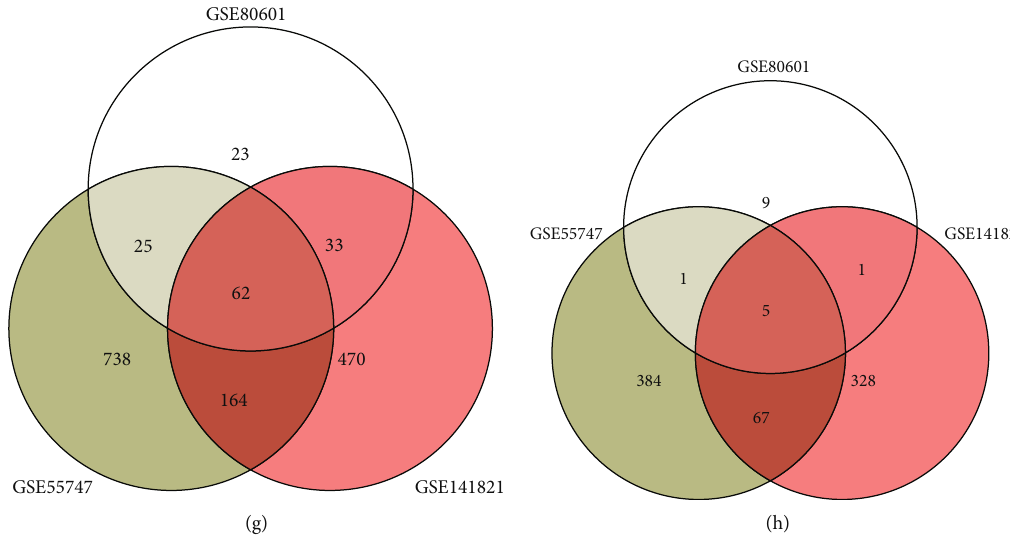
Figure 1: Identi fi cation of DEGs in CCl -treated mouse liver samples. DEGs were obtained by comparing untreated and CCl4-induced 4 fi brotic mouse liver tissues from three GEO datasets: GSE14182, GSE55747, and GSE80601. (a) – (c)) Volcano plot of the distribution of all -treated liver samples from GSE14182, GSE55747, and GSE80601, respectively, with a threshold DEGs between untreated control and CCl 4 (foldchange)| > 1 and adjusted P < 0 : 05 (the brick red, upregulated DEGs; grass green: downregulated DEGs; grey: unchanged). of |log 2 -treated vs Control) from GSE14182, GSE55747, and GSE80601, respectively. (d) – (f) The heatmap plot of DEGs across the samples (CCl 4 Colors above the heatmap indicate sample groups. Each row of the heatmap represents the normalized expression values of one di ff erentially expressed gene across all samples (grass green, low expression; brick red, high expression). (g) and (h) Venn diagram of DEGs , carbon tetrachloride; DEG, di ff erential expressed genes; GEO, Gene Expression from 3 di ff erent microarray dataset. CCl 4